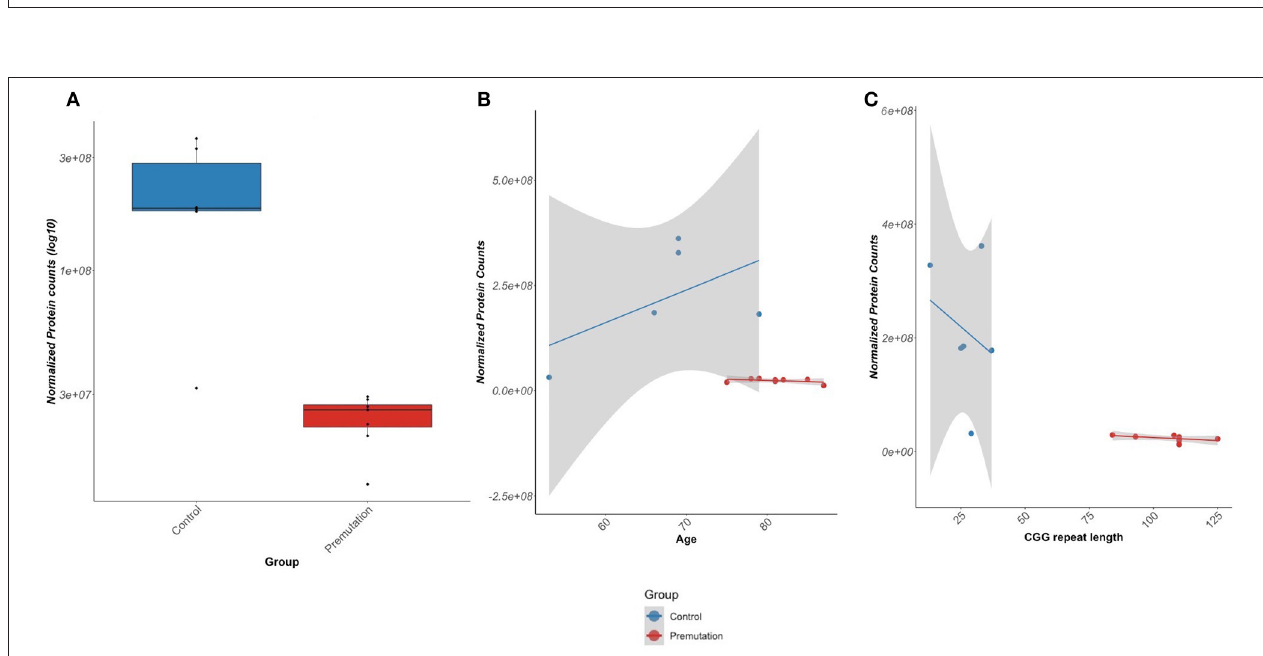
FIGURE 5 | Shared differentially abundant proteins (DAPs) between neurodegenerative disorders. (A) Venn diagram of significant [false discovery rate (FDR) < 0.2] DAPs in fragile X-associated tremor/ataxia syndrome (FXTAS), Alzheimer’s Disease (AD), and Parkinson’s Disease (PD). (B) Log2 fold change values of proteins shared between FXTAS, PD, and